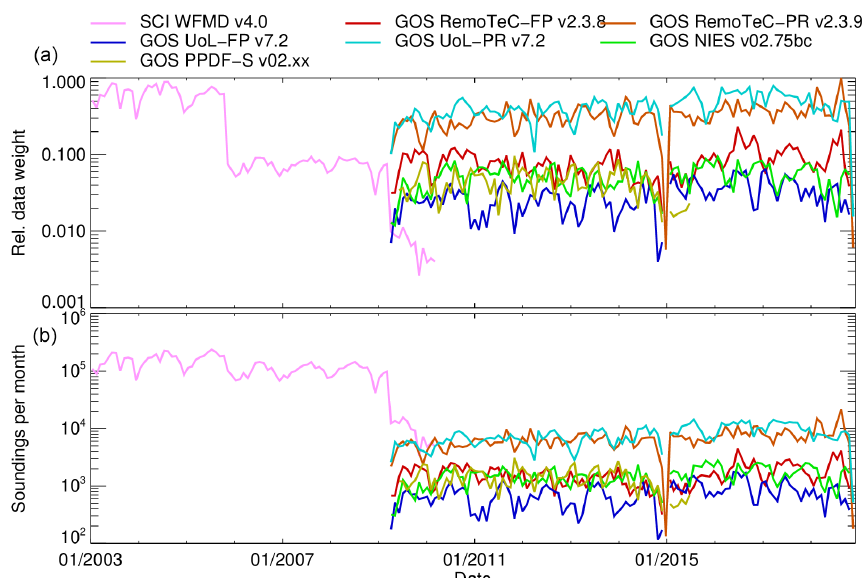
Figure 8. As Fig. 6 but for XCH 4